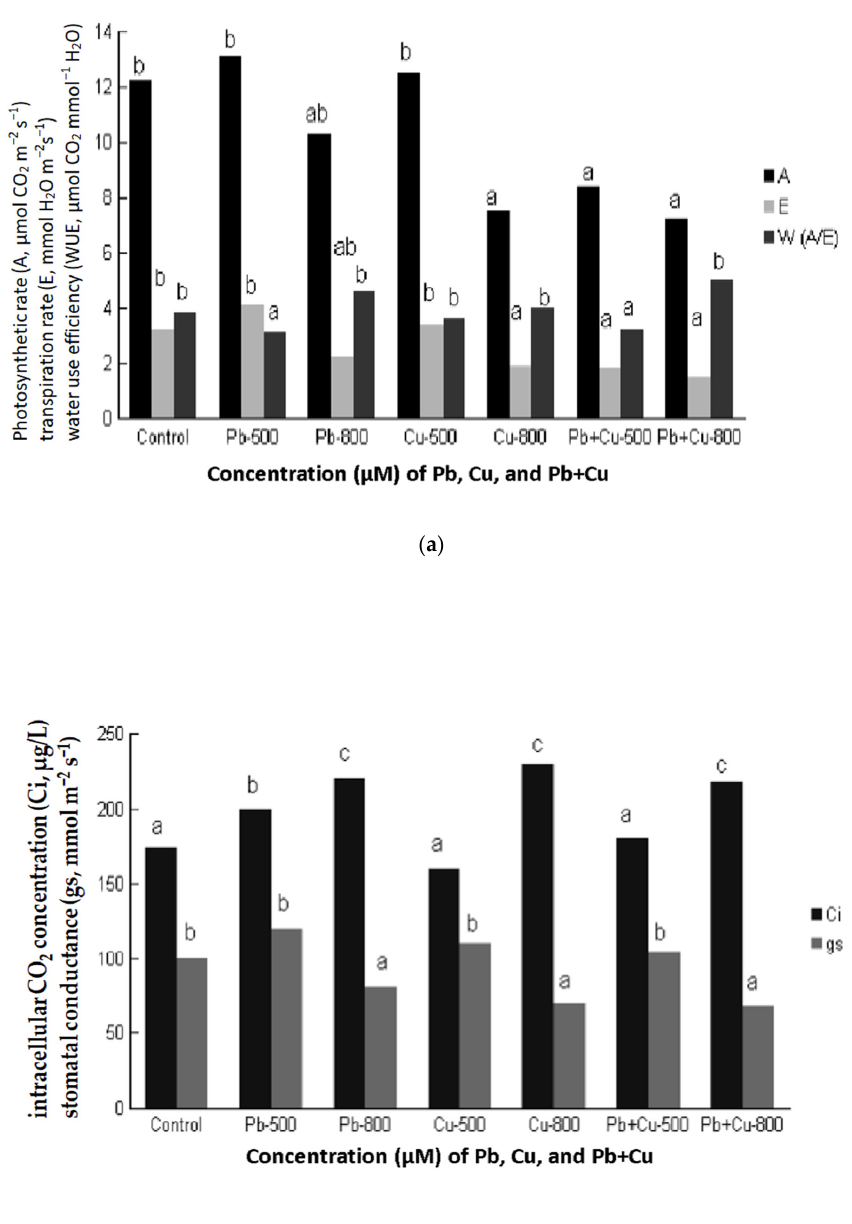
Figure 1. ( a ) Effects of Cu and Pb concentration (0 µ M, 500 µ M Pb, 800 µ M Pb, 500 µ M Cu, 800 µ M Cu, 500 µ M Cu + Pb, 800 µ M Cu + Pb) in the nutrients solution on leaf net photosynthetic rate (A, µ mol CO 2 m − 2 s − 1 ); transpiration rate (E, mmol H 2 O m − 2 s − 1 ) and water use efficiency (WUE, μ mol CO 2 mmol − 1 H 2 O) of the youngest fully expanded leaf of Citrus aurantium L.plants. Each value is the mean of nine replicates. Means of the same parameter followed by different letters are significantly different. ( p ≤ 0.05). ( b ) Effects of Cu and Pb concentration (0 µ M, 500 µ M Pb, 800 µ M Pb, 500 µ M Cu, 800 µ M Cu, 500 µ M Cu + Pb, 800 µ M Cu + Pb) in the nutrients solution on intracellular CO 2 concentration (Ci, µ g/L), and stomatal conductance (gs, mmol m − 2 s − 1 ) of the youngest fully expanded leaf of Citrus aurantium L. plants. Each value is the mean of nine replicates. Means of the same parameter followed by different letters are significantly different ( p ≤ 0.05). The value of transpiration rate (E) in the treatments 800 µ M Cu and 800 µ M Cu + Pb was significantly decreased. Besides the treatments of 500 µ M Cu and 500 µ M Cu + Pb that were increased compared to control, all the other treatments were decreased. Finally,